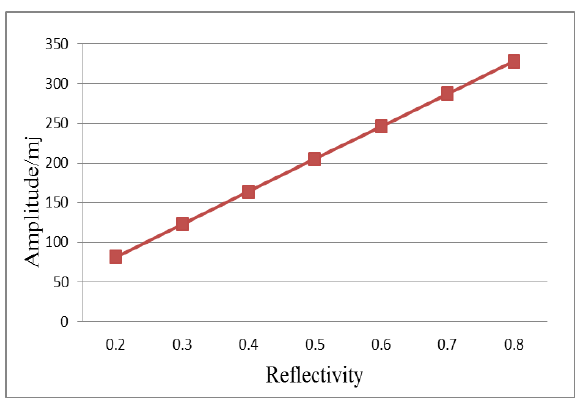
Figure 3. Amplitude of different